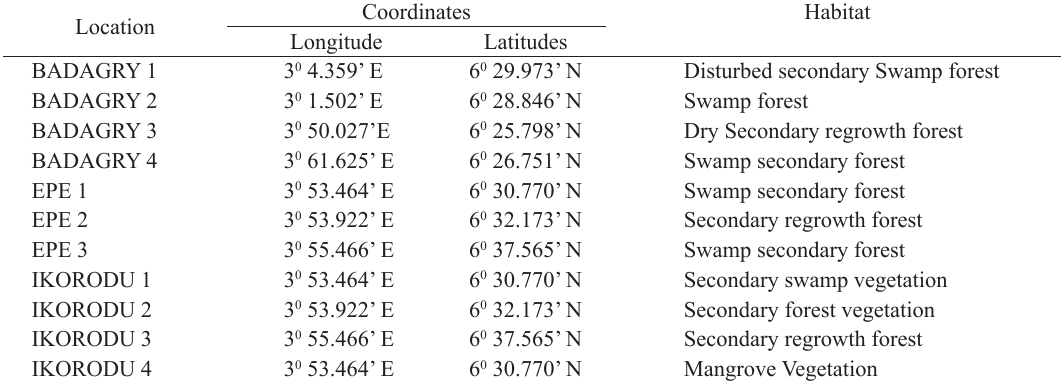
Table 1. Locality information showing the geographic coordinates and habitats